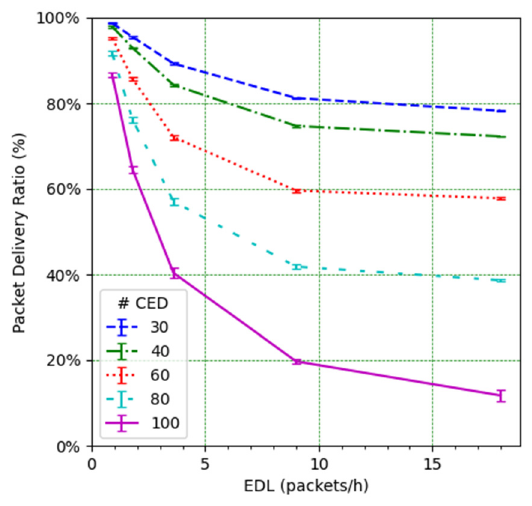
Figure 10. PDR vs. EDL, from all EDs.